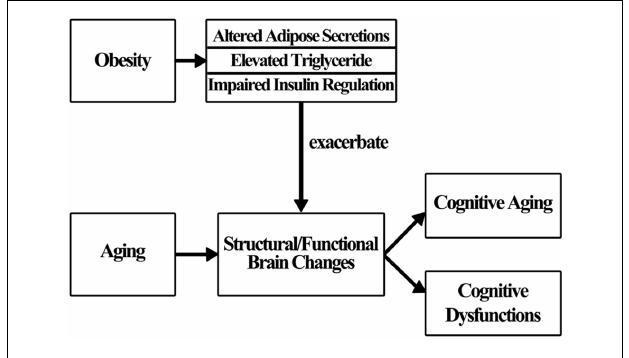
FIGURE 1 | Schematic presentation of how obesity influences cognition